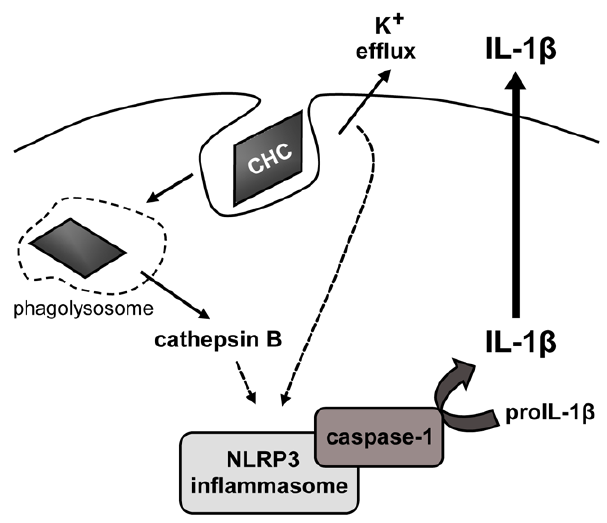
Figure 7. Proposed mechanism of cholesterol crystal (CHC)- induced inflammasome activation. CHCs are phagocytosed by macrophages, causing lysosomal destabilization and leakage of cathepsin B to cytoplasm, where the enzyme indirectly activates the NLRP3 inflammasome. Lowering of intracellular potassium concentra- tion, stemming from potassium efflux caused by phagocytosed CHCs, is also required for NLRP3 activation.